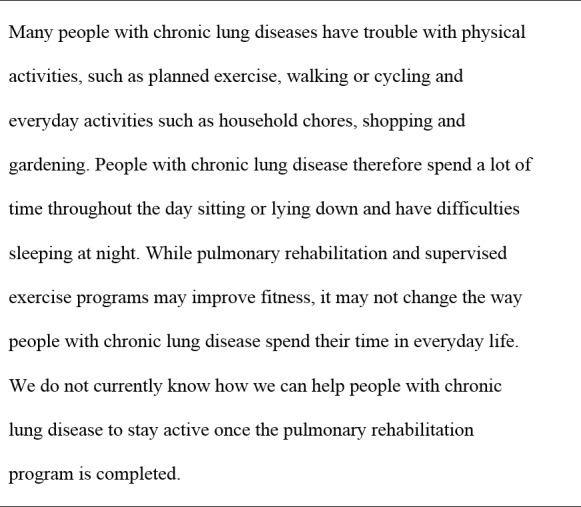
Context setting information.